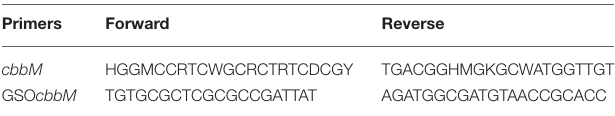
TABLE 1 | Sequences of the designed degenerated ( cbbM ) and specific (GSO cbbM ) primers. Primers